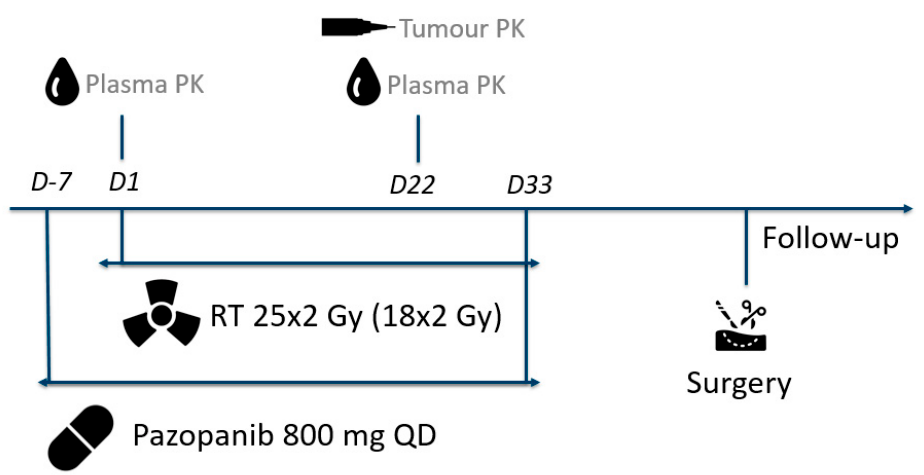
Figure 1. Overview of study procedures for the PASART-II pharmacokinetic study.